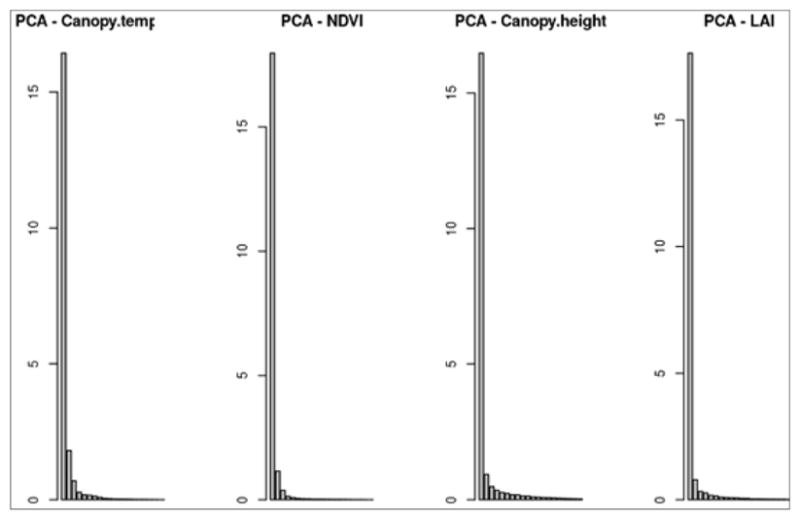
Principal Component Analysis (PCA) results for each drought-related trait; showing variation within each component, from left to right: canopy temperature, NDVI, canopy height, and LAI. Y-axis is percent variation explained by PC on X-axis.